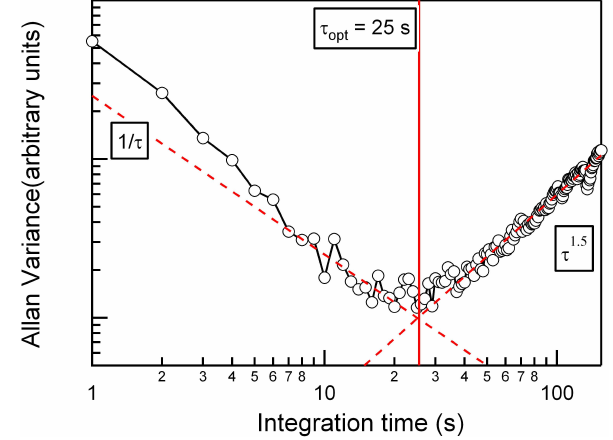
Fig. 8. Allan variance plot, calculated using the normalized count rate at − 45Th, from 15min of continuous 1Hz sampling on the formic acid calibration standard. At low integration times, white noise is the dominate source of